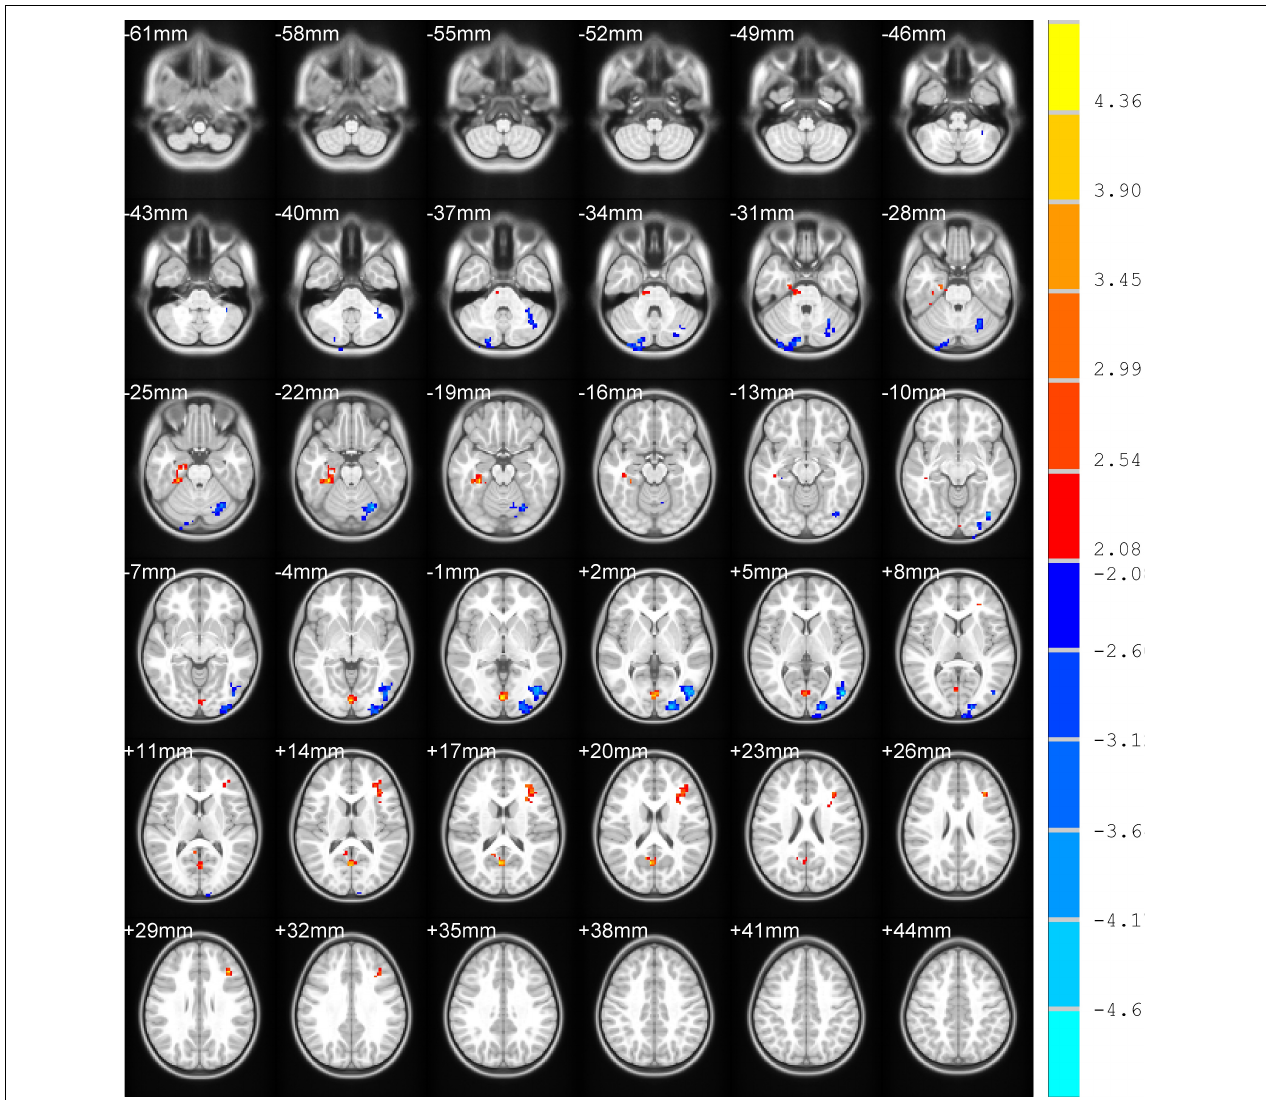
FIGURE 2 | Compared with HC, TOF children had higher ALFF values in the left medial prefrontal cortex, left cingulum, and right parahippocampal gyrus, but lower ALFF values in the bilateral cerebellum, left middle inferior occipital gyrus, and left inferior occipital gyrus. AlphaSim correction with P < 0.05; cluster size >